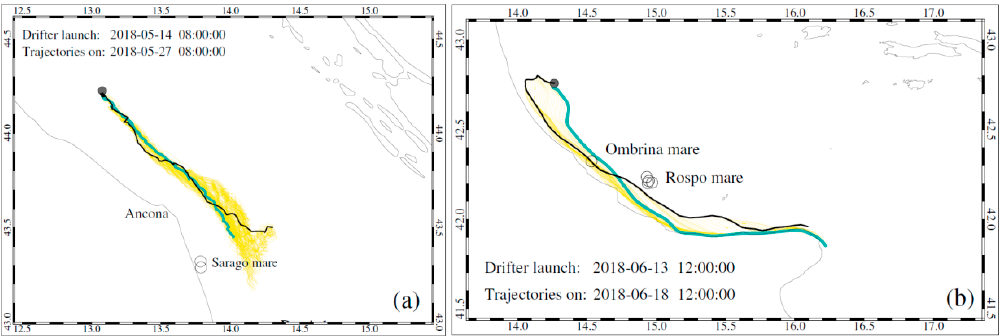
Figure 6. Observed (black thick line) and mean simulated (yellow lines) trajectories for the drifters LCE00234-1 with a drogue at 20 m ( a ), and LCE00234-2 with a drogue at 1 m ( b ), below the sea surface. The green thick line represents the mean trajectory of the particles released at the beginning of simulations. The circles mark the oil platforms.